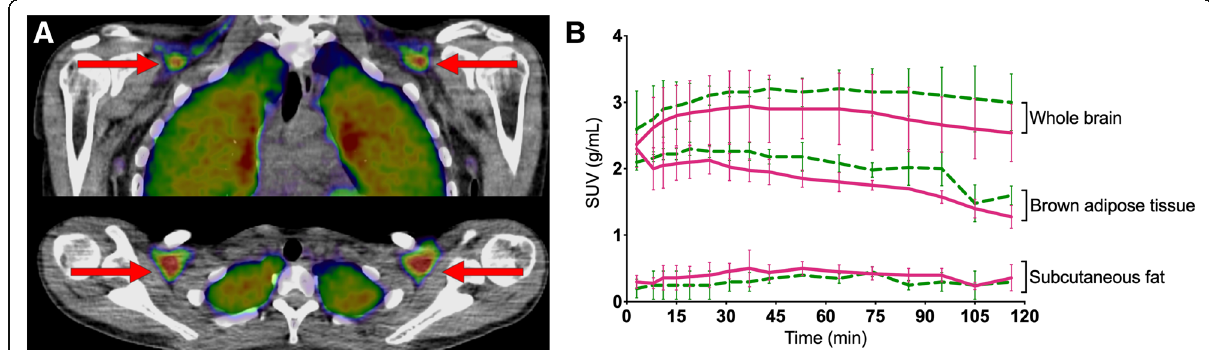
Fig. 4 Anatomical localization of uptake in presumed brown adipose tissue (BAT) ( a ). Standard uptake value (SUV) curves for BAT, whole brain, and subcutaneous fat ( b ). Full line (pink) denotes 11 C-Cimbi-36 and dotted line (green) denotes 11